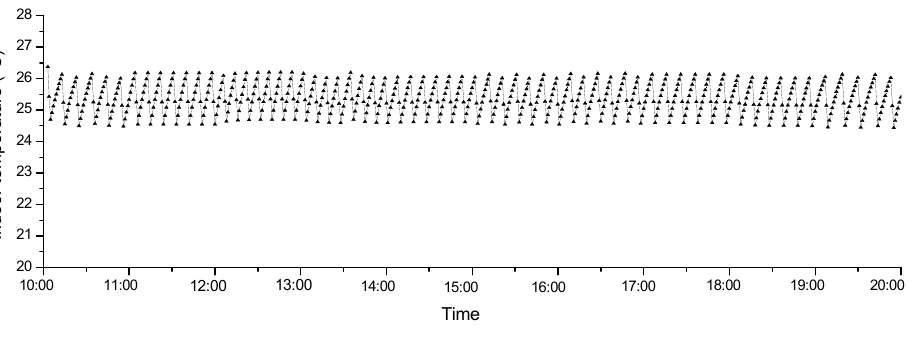
Figure 2. Indoor temperature fluctuation in a typical